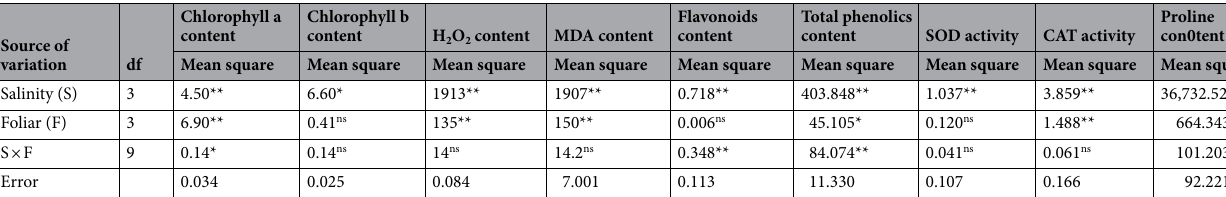
Salinity levels